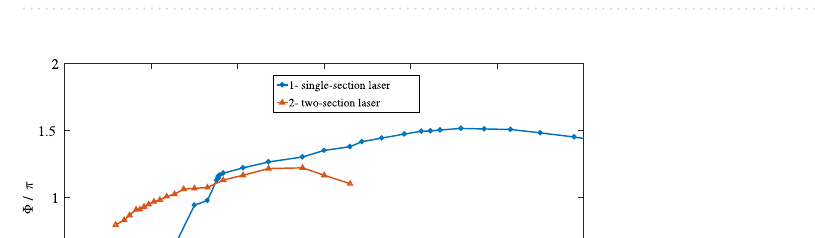
Figure 8. Dynamics for smaller T 2 , out of the coherent mode-locking regime. ( a ) Intensity-time trace A the same as in Fig. 6b and T 2 = 25 ps (10 times smaller than in Fig. 6b). ( b ) A ( t ), and ( c ) A 3 15 and N 0 = 0.45 · 10 cm − , 10 times larger than in ( a ), providing the same excess above threshold as in Fig. 6b. Other parameters are the same as in Fig. 6. This figure was created with Matlab R2016b (http://www.mathw orks. com).